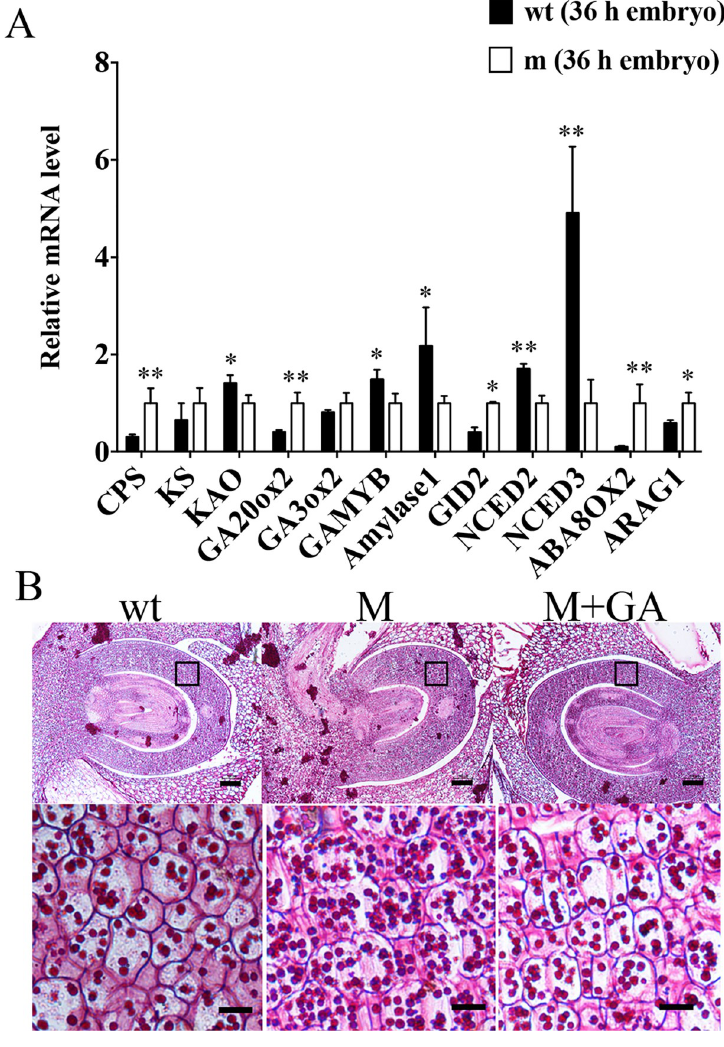
Fig 6. Analyses on the expression of GA and ABA metabolism and responsive genes and the degradation of starch. (A) Comparison on the expression of GA and ABA metabolism and responsive genes between the embryos from wild-type and mutant through qRT-PCR. Data are means ± SE (n = 3). Significant difference was determined by Student’s t-test ( � p < 0.05, �� p < 0.01). (B) Microscope observation of the starch granules in the paraffin sections of rice embryos from wt, m and m treated with exogenous GA 3 (m+GA). The down-side panels are the enlaged rectangle areas of their corresponding up-side panels. Bars = 15 μ m. All the embryos were from the seeds at 36 h after